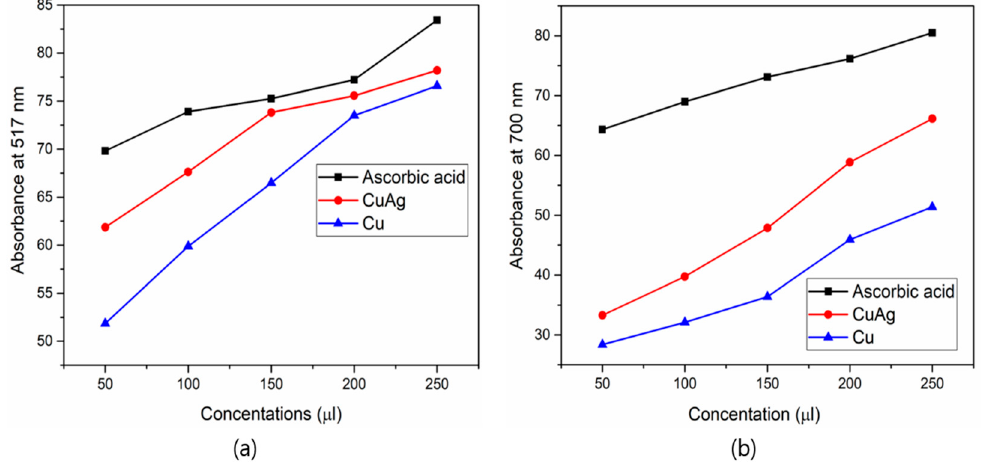
Figure 7. ( a ). Antioxidant activity Cu-Ag NPs by DPPH assay at a characteristic absorption of 517 nm ( b ) antioxidant activity Cu-Ag NPs by DPPH assay at a characteristic absorption of 700 nm.